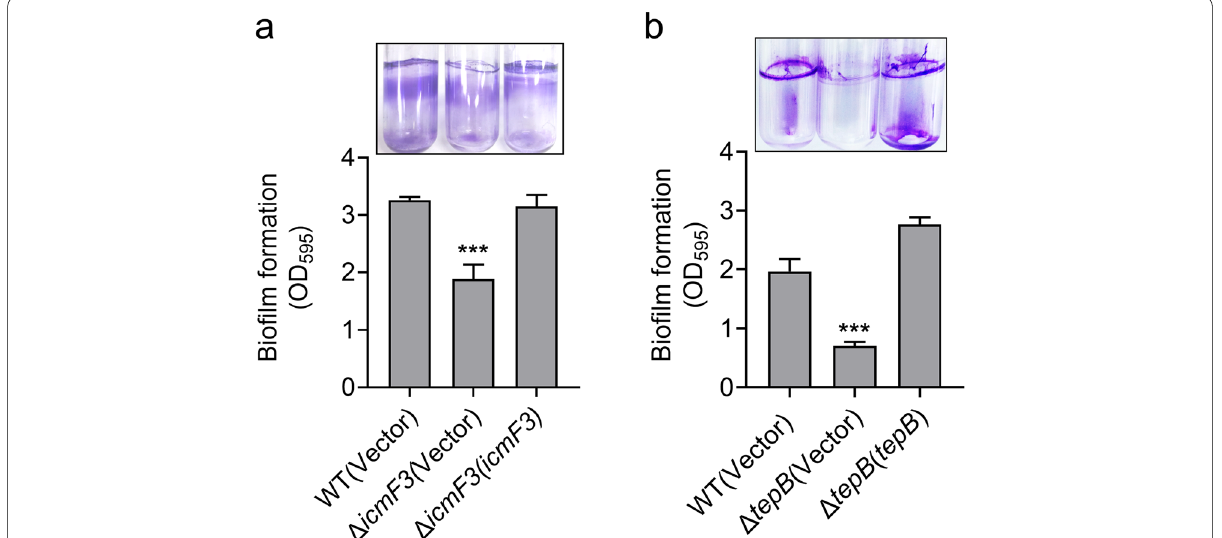
Fig. 5 H3-T6SS and TepB influence biofilm formation. a and b Saturated bacterial cultures were diluted 100-fold in fresh TSB medium. After vertical incubation for 2 days with shaking at 120 rpm at 37 °C, biofilm formation of the strains was determined by crystal violet staining and quantified using optical density measurement. Data represent the mean SEM of three biological replicates, each of which was performed with three ± technical replicates. *** P <